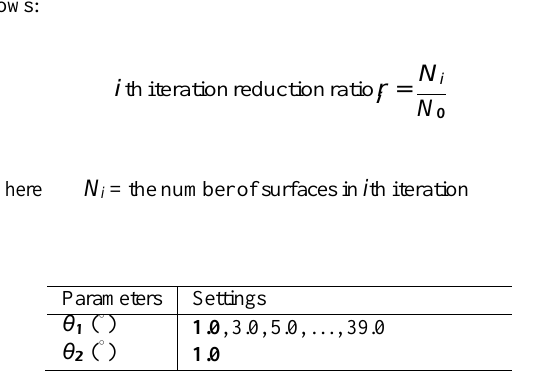
Algorithm 1. Our measure in this experiment is defined as fol-